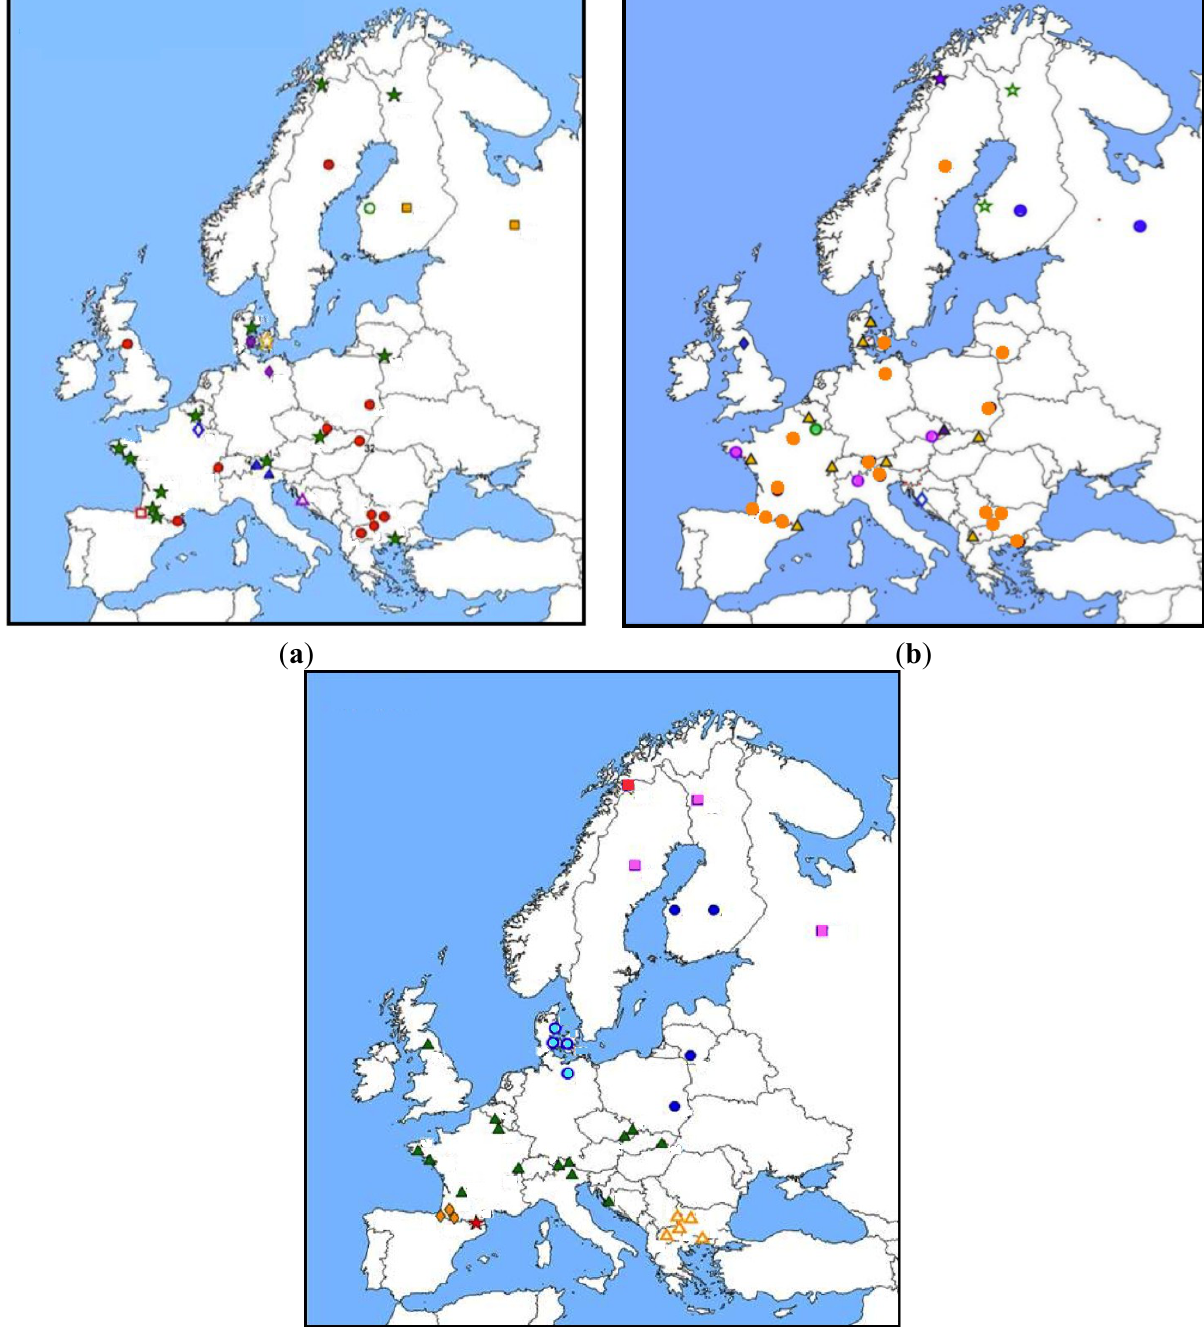
Figure 1. Distribution of Mhc ( a ) Dqa and ( b ) Drb exon2; and ( c ) mitochondrial cytochrome b ( cyt b ) polymorphism in M. glareolus populations over Europe (from [95,98]). Spatial clustering was defined using Spatial Analysis of MOlecular VAriance (S AMOVA ). Populations belonging to a same cluster are represented by a same